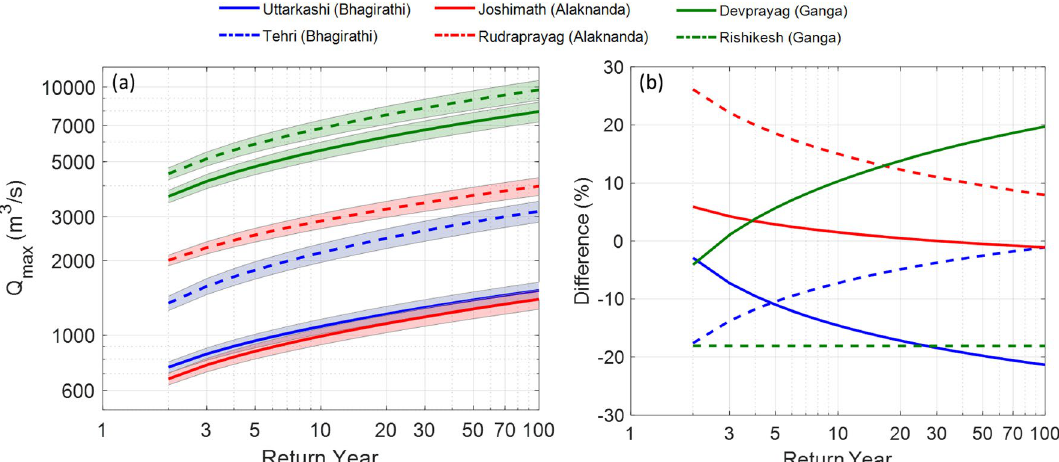
Figure 7. (a) Extreme flows at different return periods at the six stations of the UGB. The Rishikesh (downstream station) and Joshimath (upstream Alaknanda basin) stations show the highest and lowest extreme flows at different return periods. The standard errors of the scale and location parameters of the Gumbel distribution are used to predict the error bound and shown using shaded regions around each return level curve. The details of 95% confidence bounds around the prediction of return level for each station are given in Supplementary. (b) Post-and pre-1995 differences of extreme flows at different return periods for different